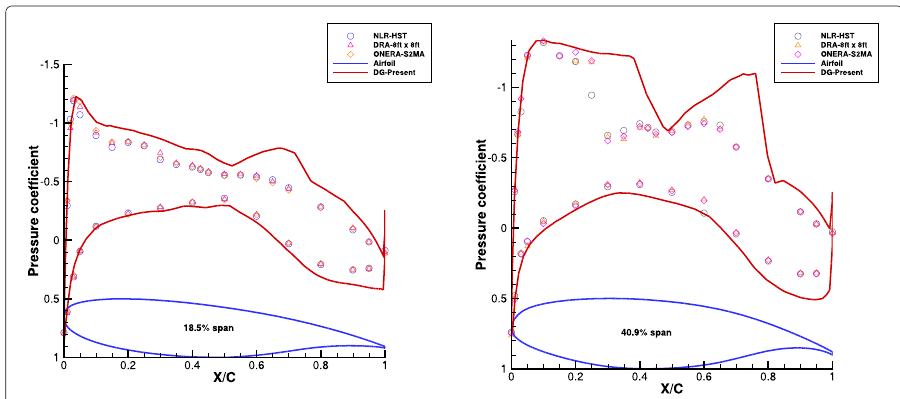
Fig. 17 Chordwise pressure distributions at several spanwise stations on DLR-F4 body